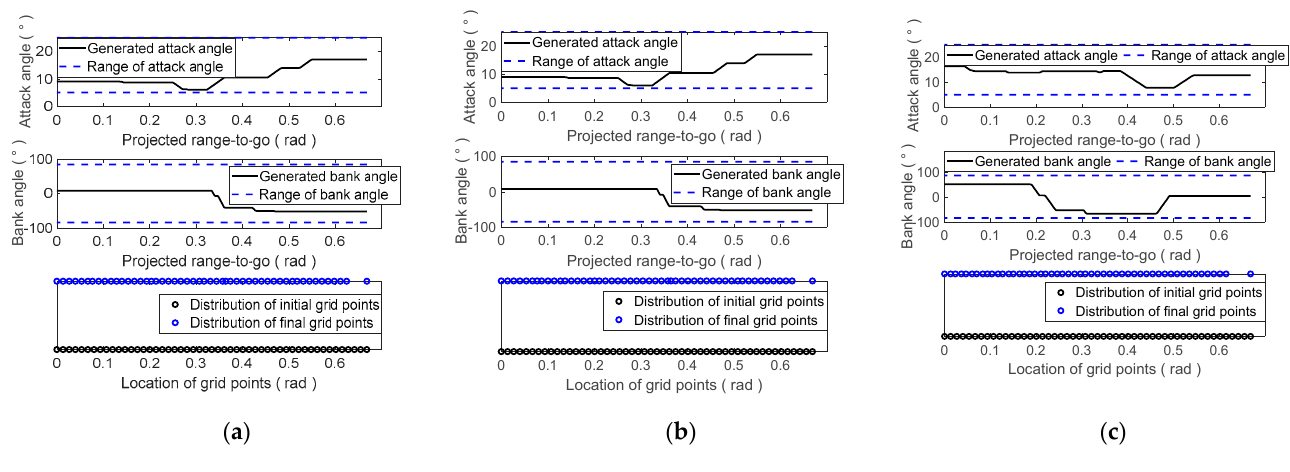
Figure 6. The generated optimized trajectories of cases: ( a ) is the longitudinal and lateral trajecto- ries of case 1; ( b ) is the longitudinal and lateral trajectories of case 2; ( c ) is the longitudinal and lat- eral trajectories of case 3.